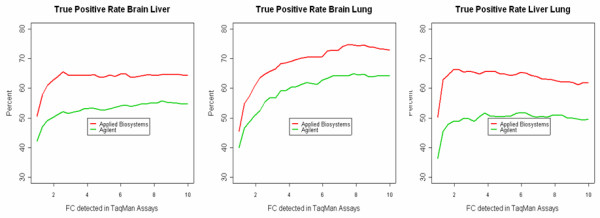
Sensitivity in detection of differential expression for different fold changes. For each platform, significantly differentially expressed genes for any given pair-wise tissues are determined using t-test at 95% significance level (p-value = 0.05). Using one-sample z-test, genes showing "at least F fold change" with 95% confidence are grouped based on TaqMan® Gene Expression Assays data set. True Positive Rates of each microarray platform was plotted as a function of Fold Change cut-off (range from 1.2 – 10) for each pair-wise tissues.